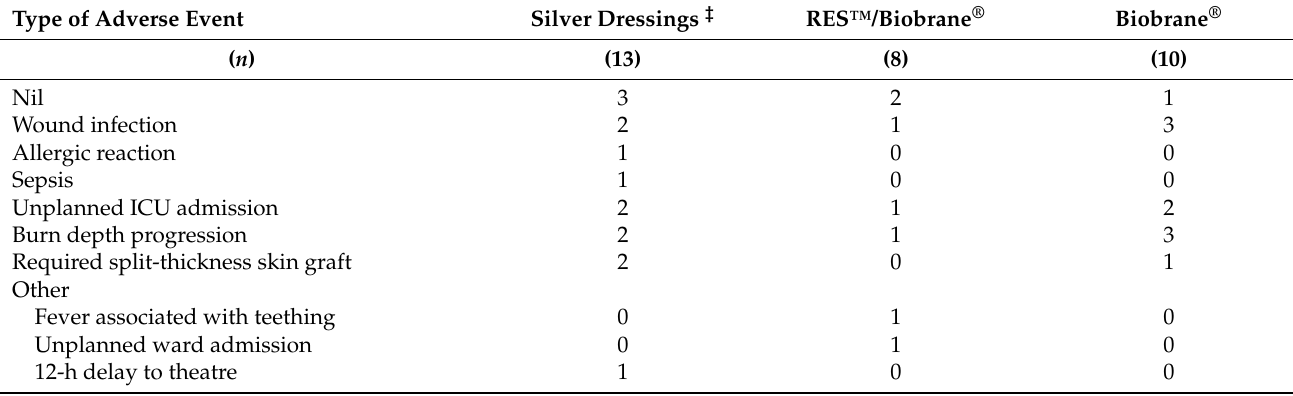
Table 6. Adverse